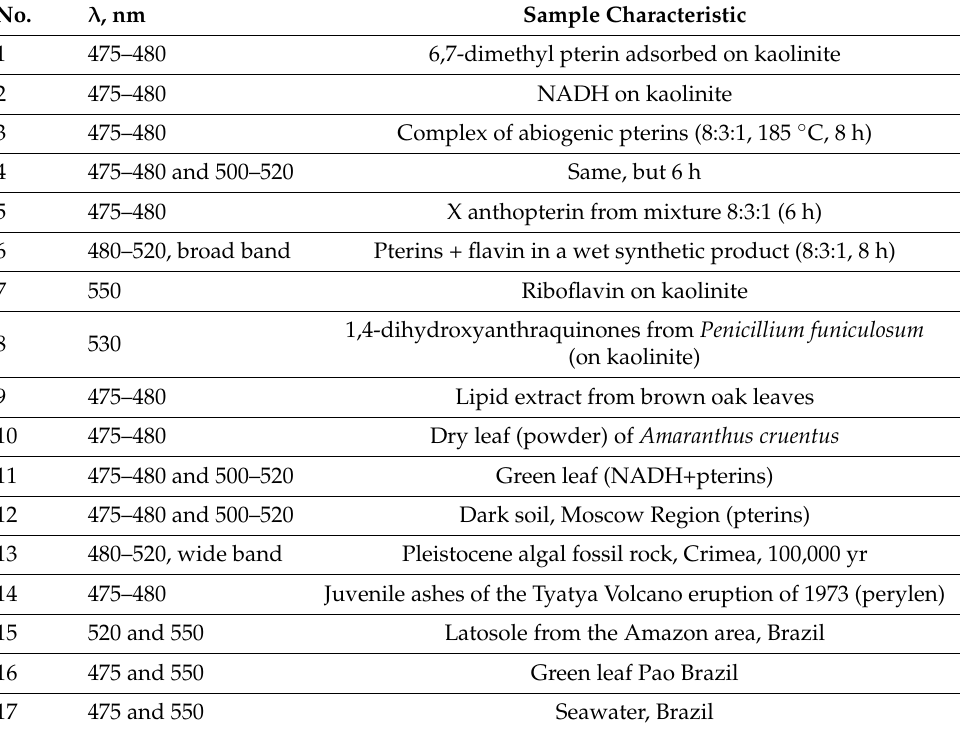
Table 1. Fluorescence maxima of natural and synthetic samples, measured by the fluorescence LIDAR ( λ = 355 nm